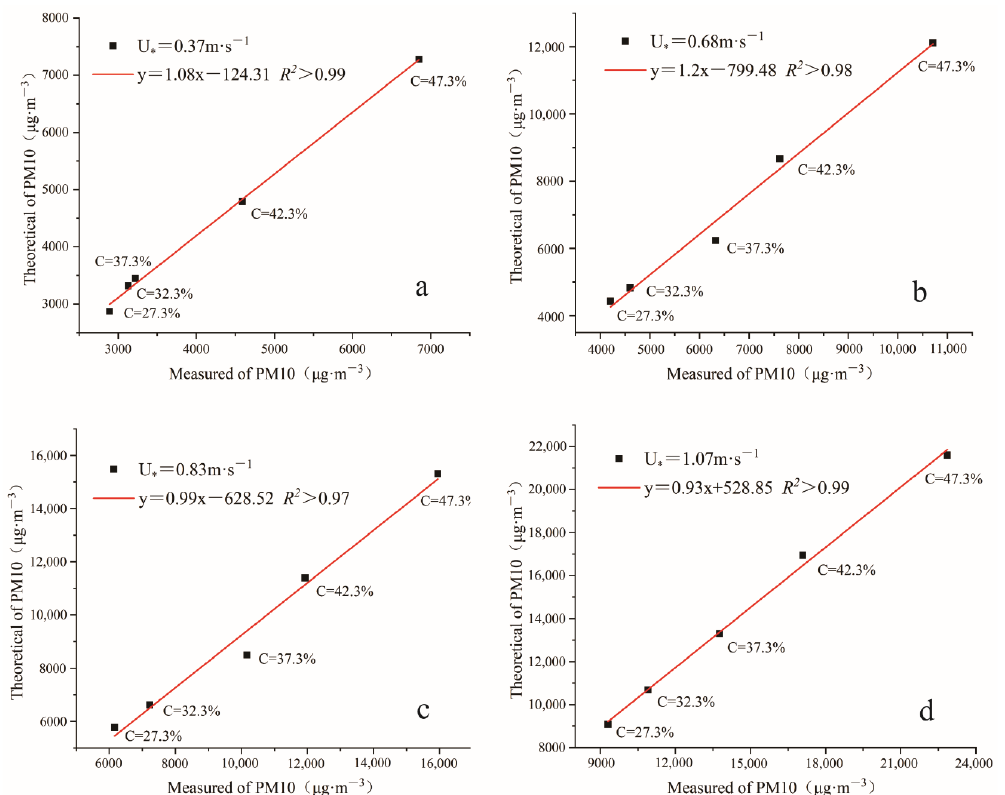
Figure 6. Correlation of measured and theoretical values of PM10 concentration under different wind velocities and surface dust contents. ( a ) U ∗ = 0.37 m · s − 1 , ( b ) U ∗ = 0.68 m · s − 1 , ( c ) U ∗ = 0.83 m · s − 1 , ( d ) U ∗ = 1.07 m · s − 1 .